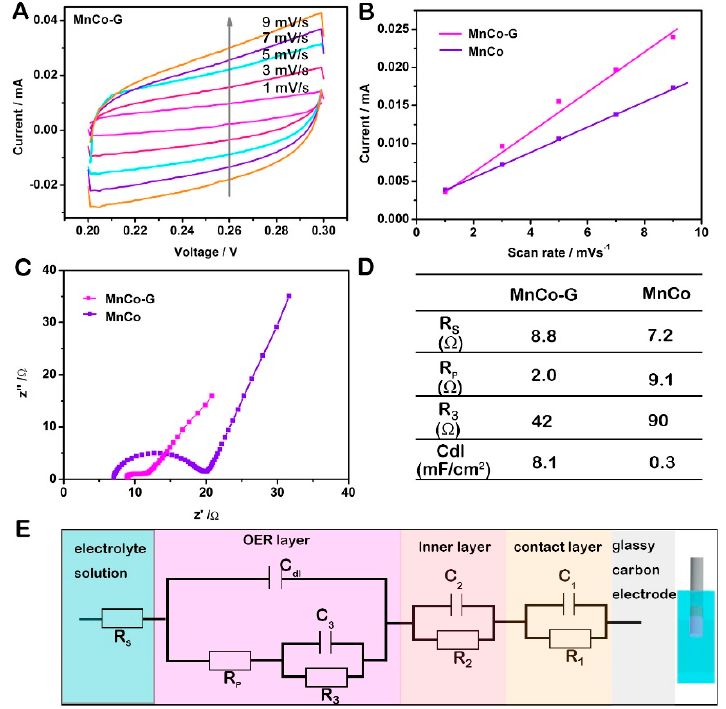
Figure 6. ( A ) CVs of the Mn-Co LDH/graphene loaded onto GCE and measured at scan rates from 1 to 9 mV s –1 ; ( B ) C dl plots for the MnCo-G and MnCo sample; ( C ) Nyquist plots of Mn-Co LDH/graphene electrode and Mn-Co LDH; ( D ) summary of the fitted values of C dl , R s , R 3 , and R p ; ( E ) the equivalent circuit for modeling impedance data. All the tests were conducted in 1M KOH.